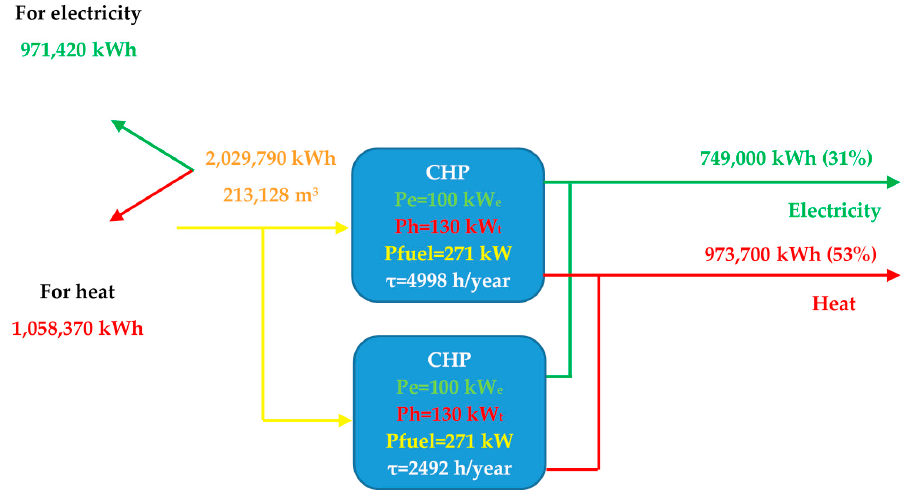
Figure 22. Cogeneration (2 × 100 kW e , 2 × 130 kW t ). Table 5. Cogeneration (2 × 100 kW e , 2 × 130 kW t ): summary results.